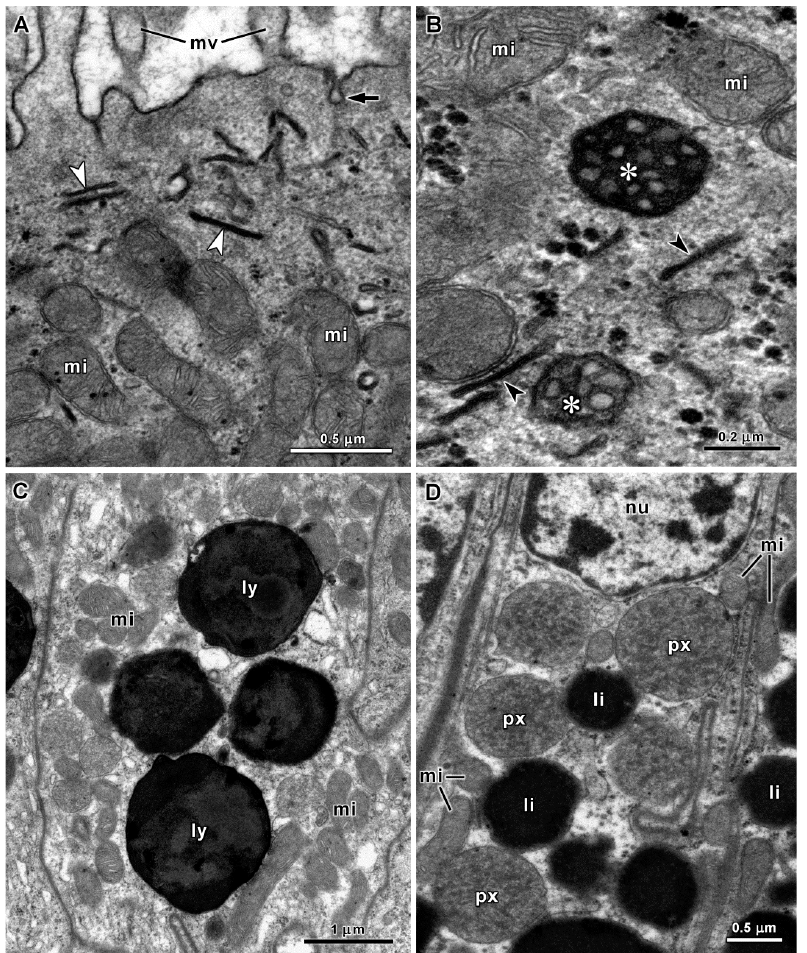
Figure 12. Ultrastructure of intestinal absorptive cells in A. fascicularis ( A , B , D ) and C. angulata ( C ). ( A , B ) A cell membrane pit (arrow), several mitochondria (mi), cisternae with electron-dense content (arrowheads) and multivesicular bodies (asterisks) in the apical region of absorptive cells. ( C ) Electron-dense lysosomes (ly) in the cytoplasm above de nucleus. ( D ) Several large peroxisomes (px) associated with lipid droplets (li) and mitochondria (mi) in the cytoplasm below the nucleus (nu). mi—mitochondria, mv—microvilli, nu—nucleus.